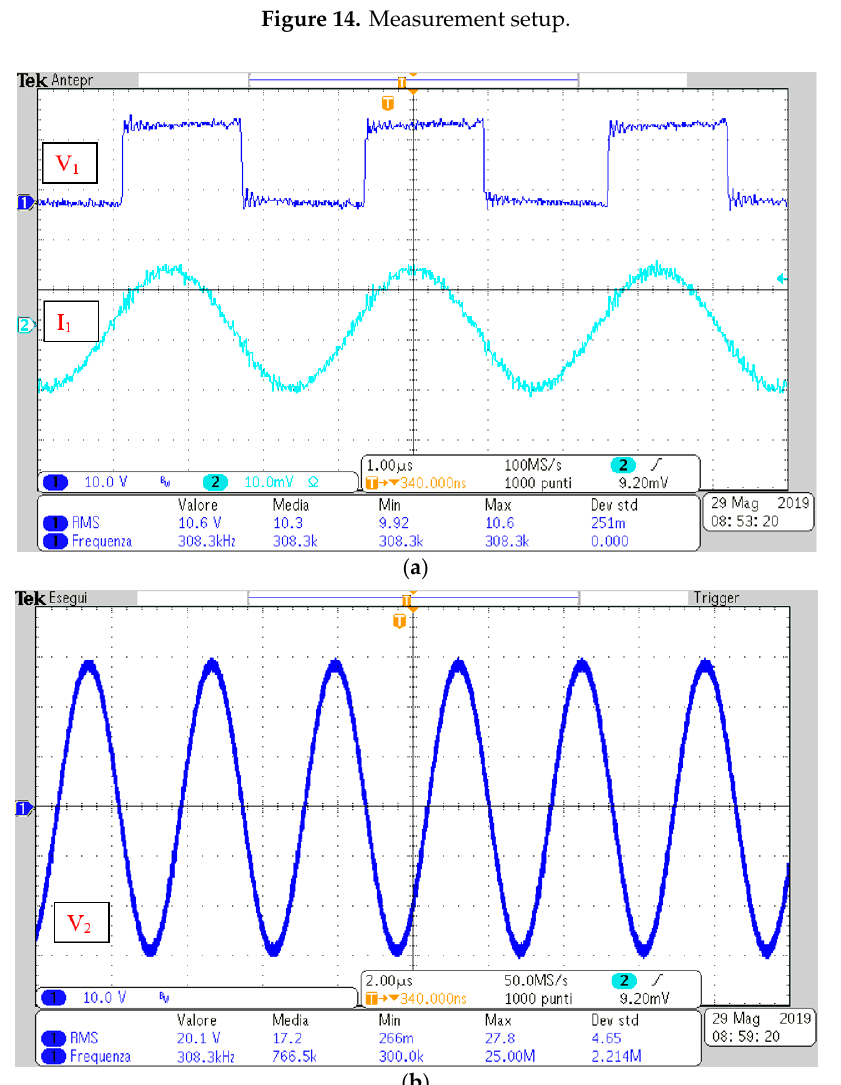
Figure 15. Measured waveforms of V 1 and I 1 ( a ) and V 2 ( b ).